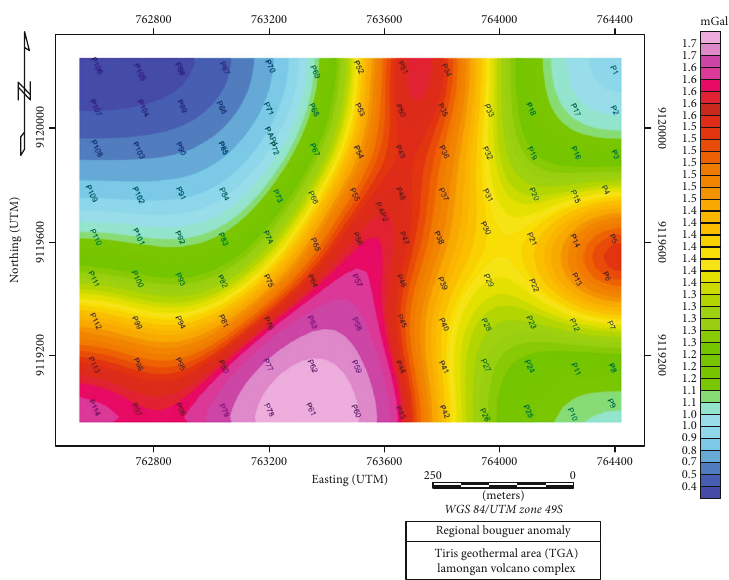
Figure 12: Regional Bouguer anomaly map at the measurement site.